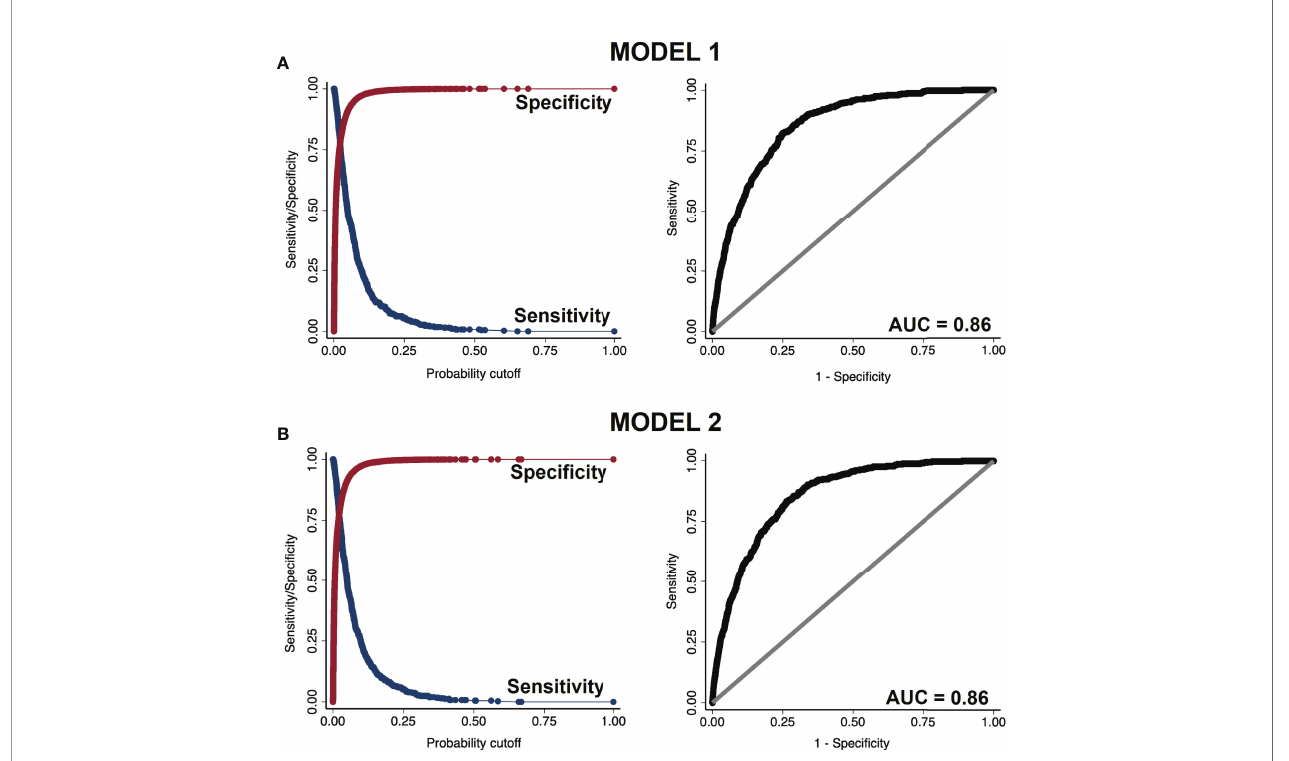
FIGURE 2 | Sensitivity vs. speci fi city plot (left panels) and receiver operating characteristic (ROC) curve (right panels) of (A) model 1 and (B) model 2.